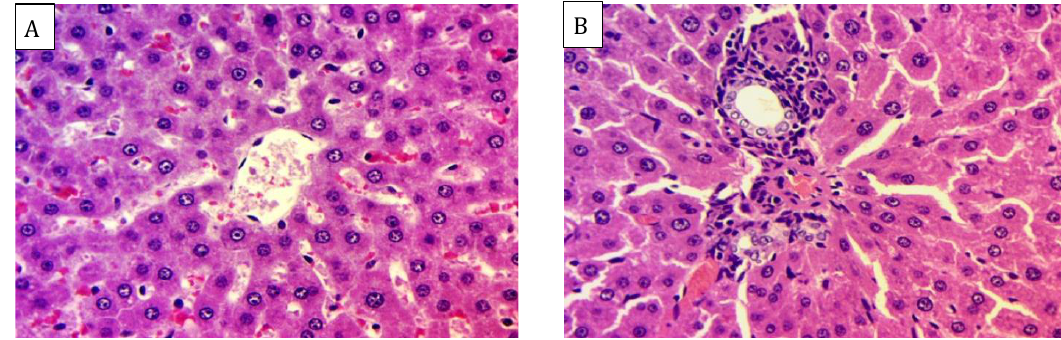
Figure 5 . Liver sections of rats fed on 1% cholesterol diet and treated orally with methanolic extract of green walnut husk, 800 mg/kg BW/day (Group 5). A: Mild congestion of the central vein and hepatic sinusoids. B. Focal infiltration of the portal area by mononuclear inflammatory cells and slight congestion of the hepatic artery and portal vein branches. H&E,